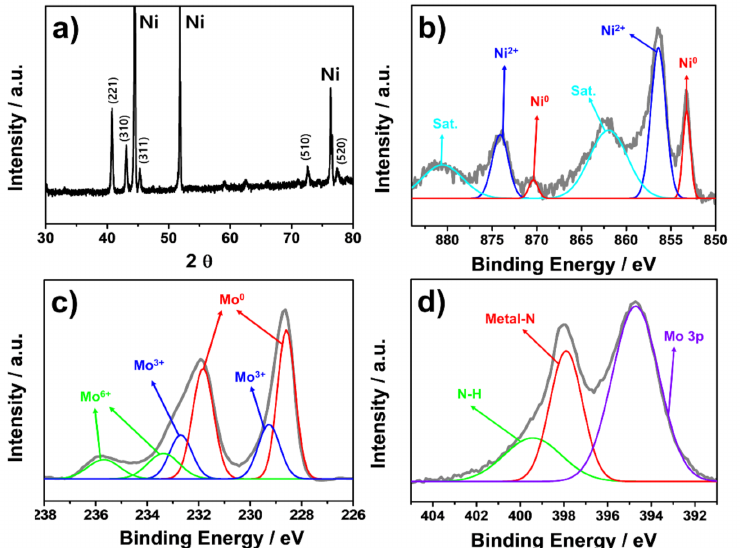
Figure 2. ( a ) XRD patterns of Ni 2 Mo 3 N/NF. XPS spectra of Ni 2 Mo 3 N/NF for ( b ) Ni 2p, ( c ) Mo 3d, and ( d ) N 1